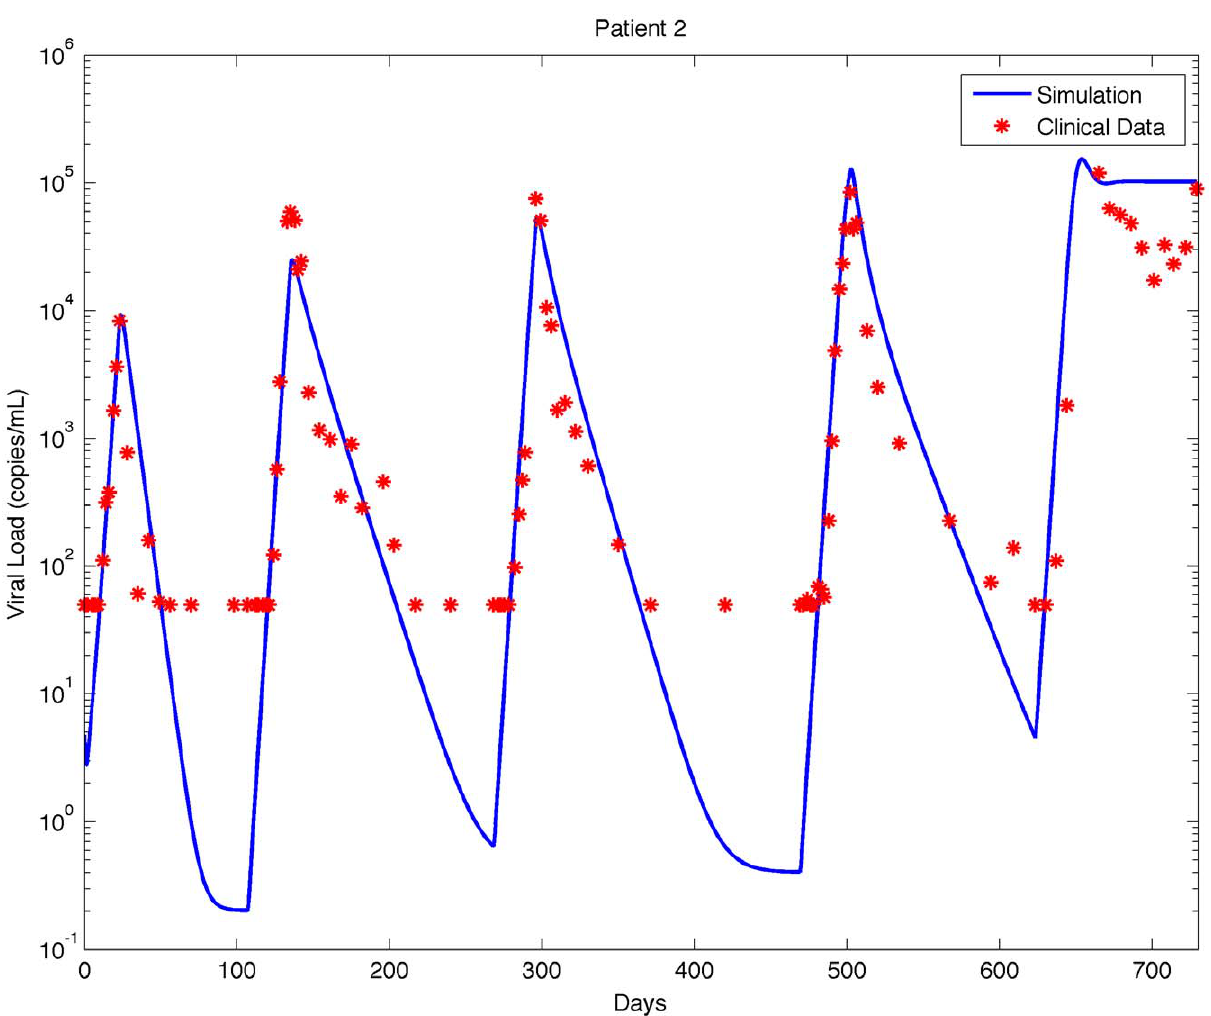
Figure 2. Model fitting for identified patients. Red star: experimental data (detection limit: 50 copies/mL); solid line: simulation based on estimated parameters.